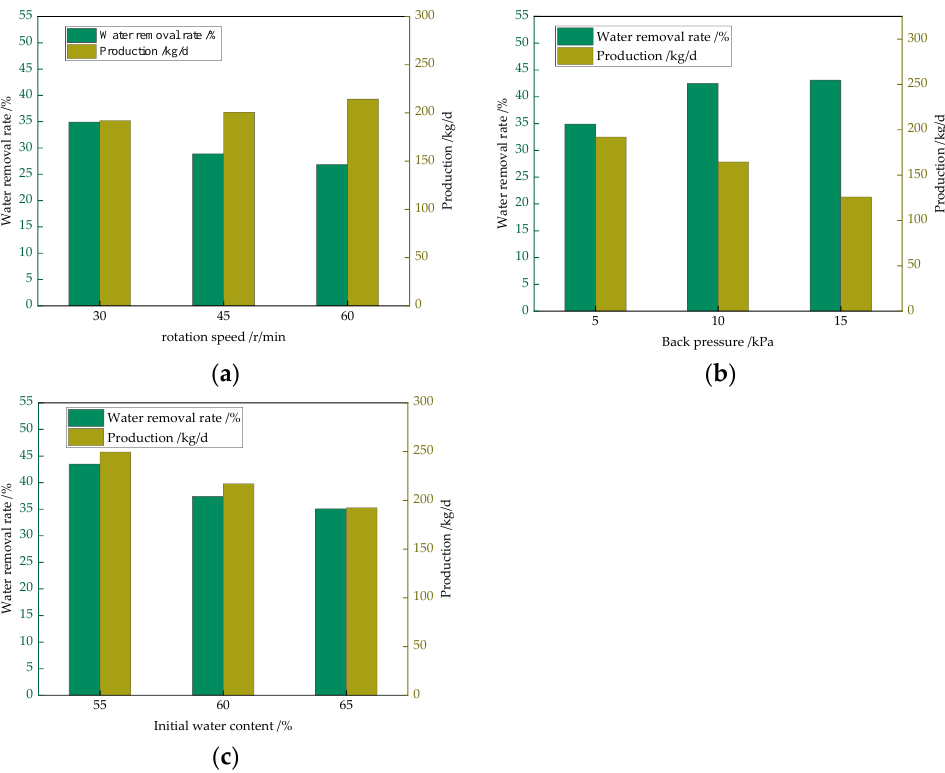
Figure 9. Influence of operation parameters on the separation performance of screw press. ( a ) Effect of rotational speed on separation performance. ( b ) Effect of back pressure on separation performance. ( c ) Effect of initial water content on separation performance.